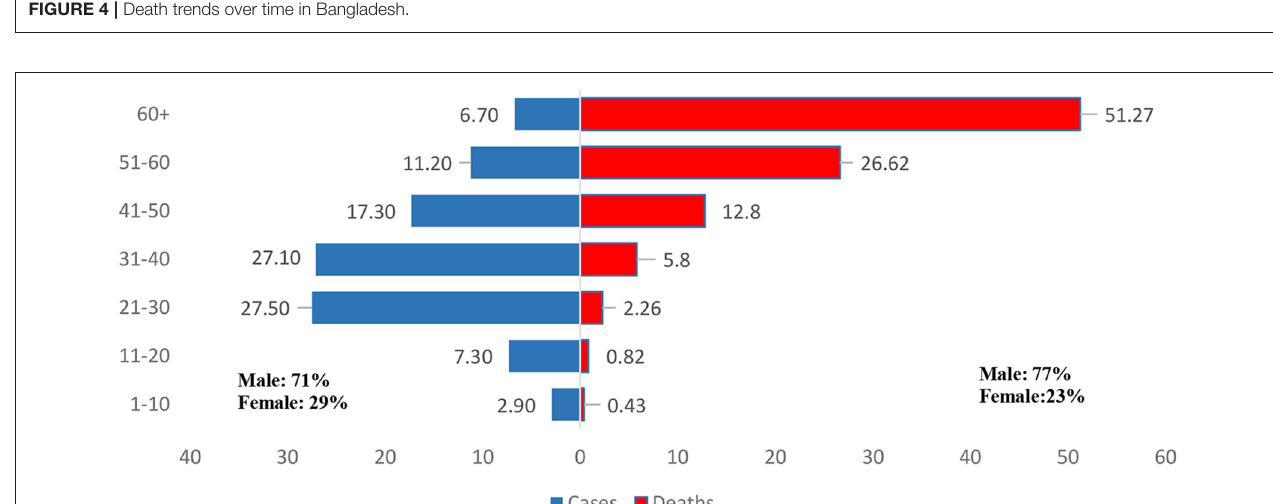
FIGURE 4 | Death trends over time in Bangladesh.